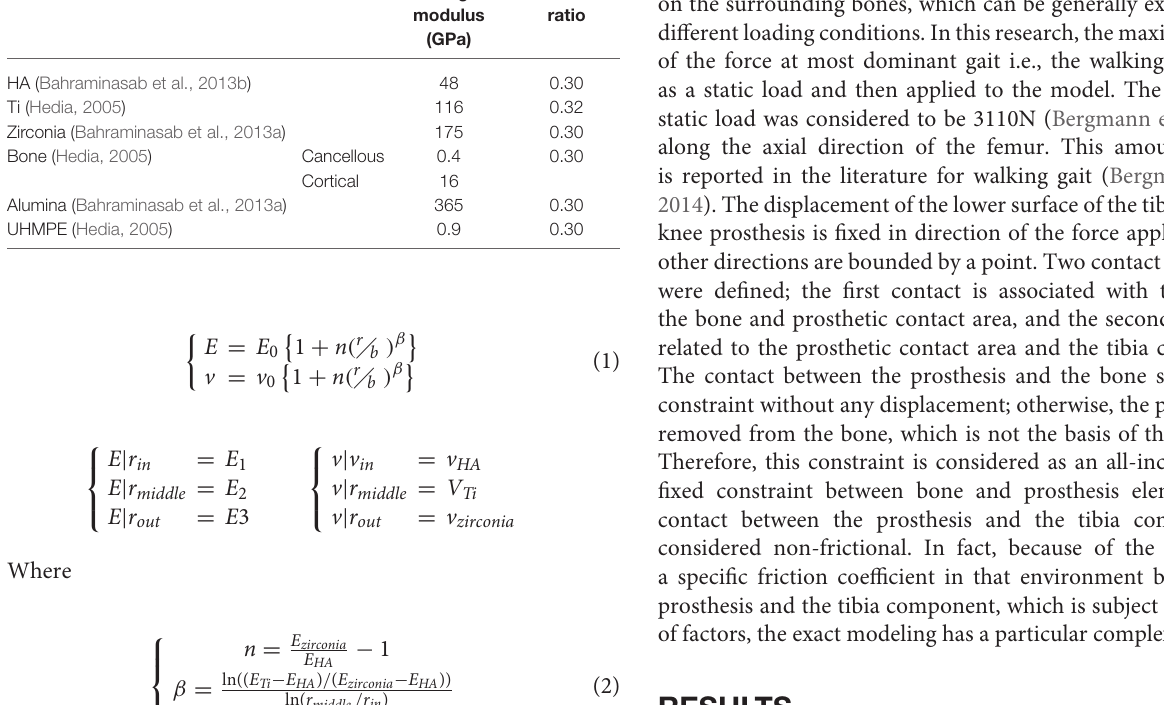
TABLE 1 | The properties of materials used in this study.